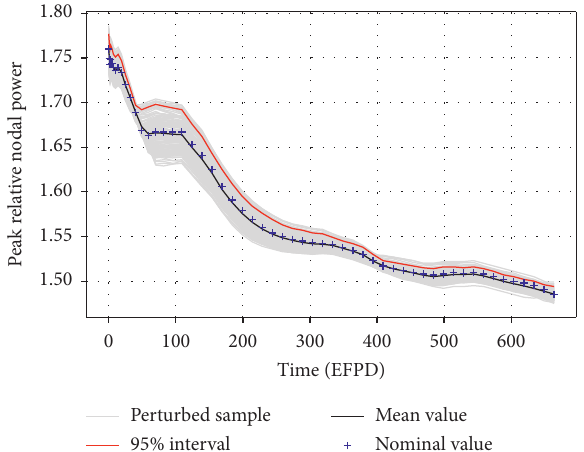
Figure 21: Peak relative nodal power of unperturbed and perturbed cases.